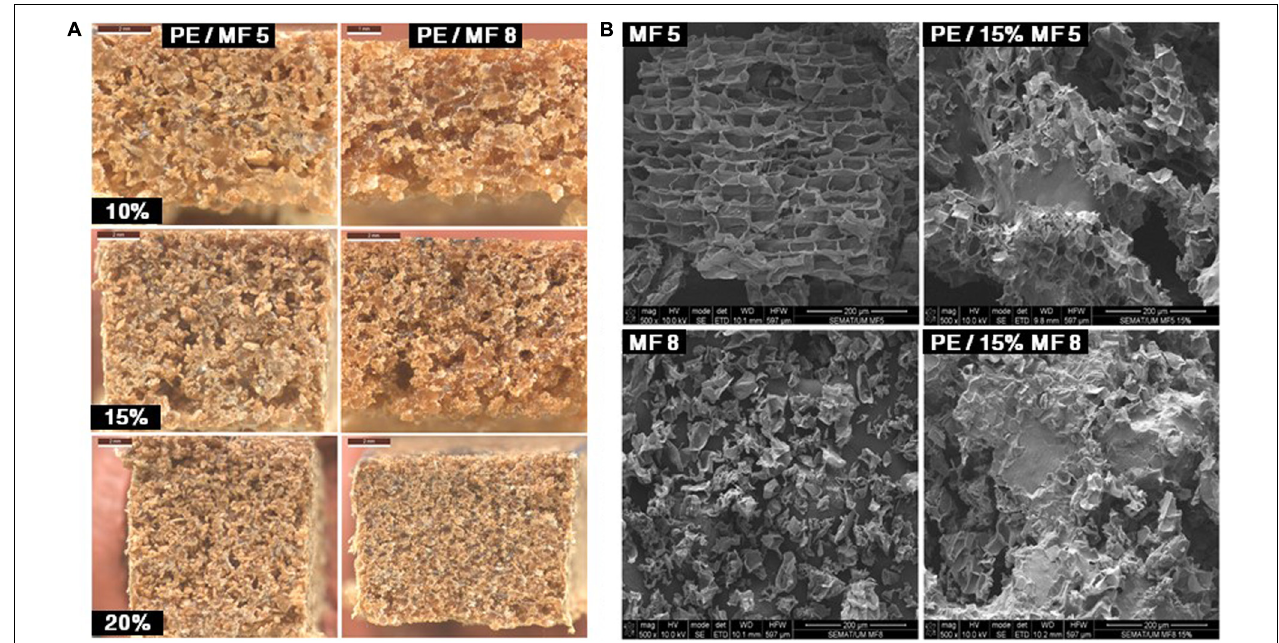
FIGURE 3 | Effect of MDPE/cork composition on the structure of the parts. (A) Images obtained by optical magnification of the cross section along the wall thickness. (B) Images obtained by SEM analysis of MF5 and MF8 cork powder and its MDPE/cork